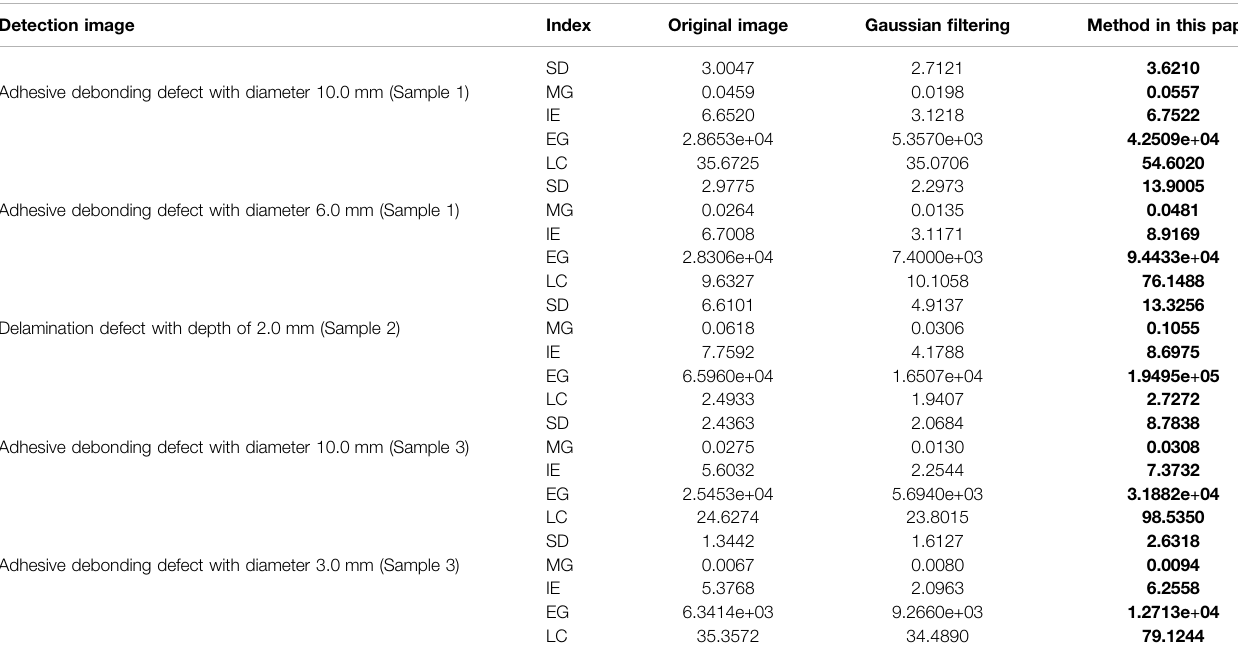
TABLE 1 | Contrast results of image objective indexes between original image and images with different methods (Bold numbers indicate the optimal value for each set of data). Detection image